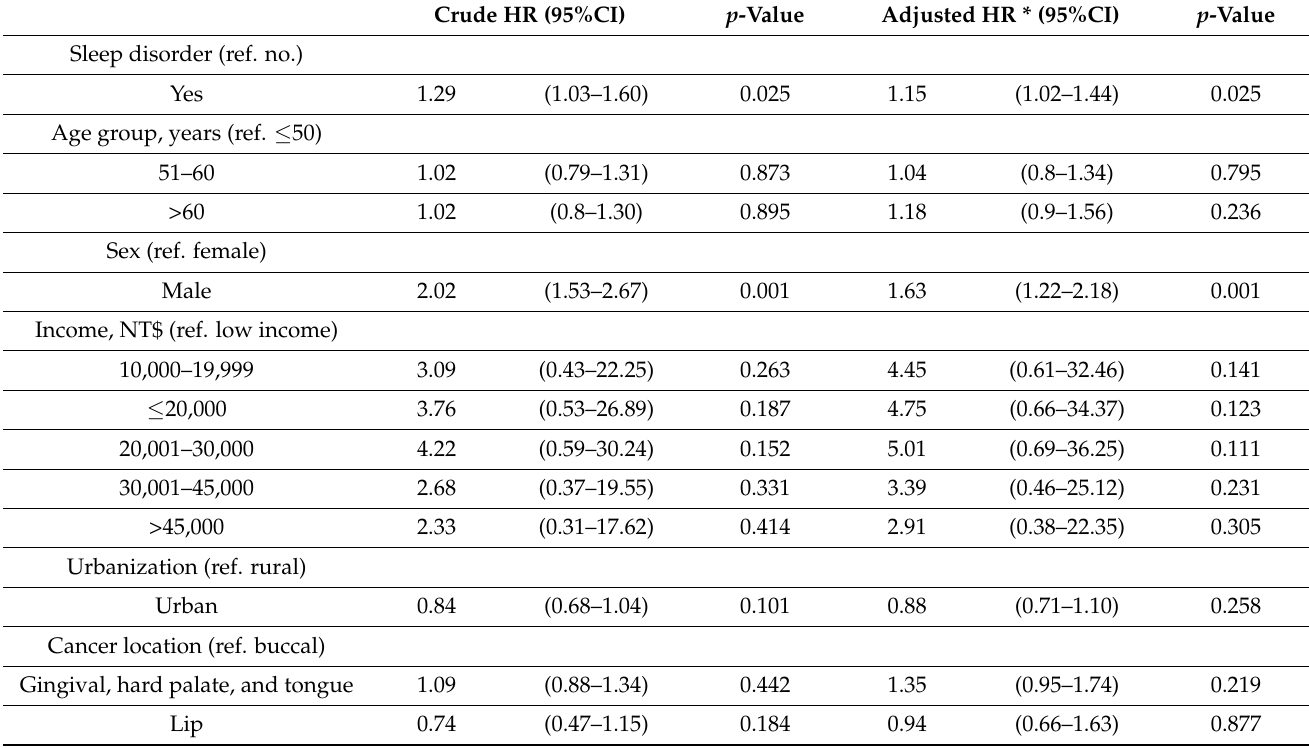
Table 4. Univariable and multivariable Cox proportional regression of distant metastasis between patients with oral cavity squamous cell carcinoma with and without sleep